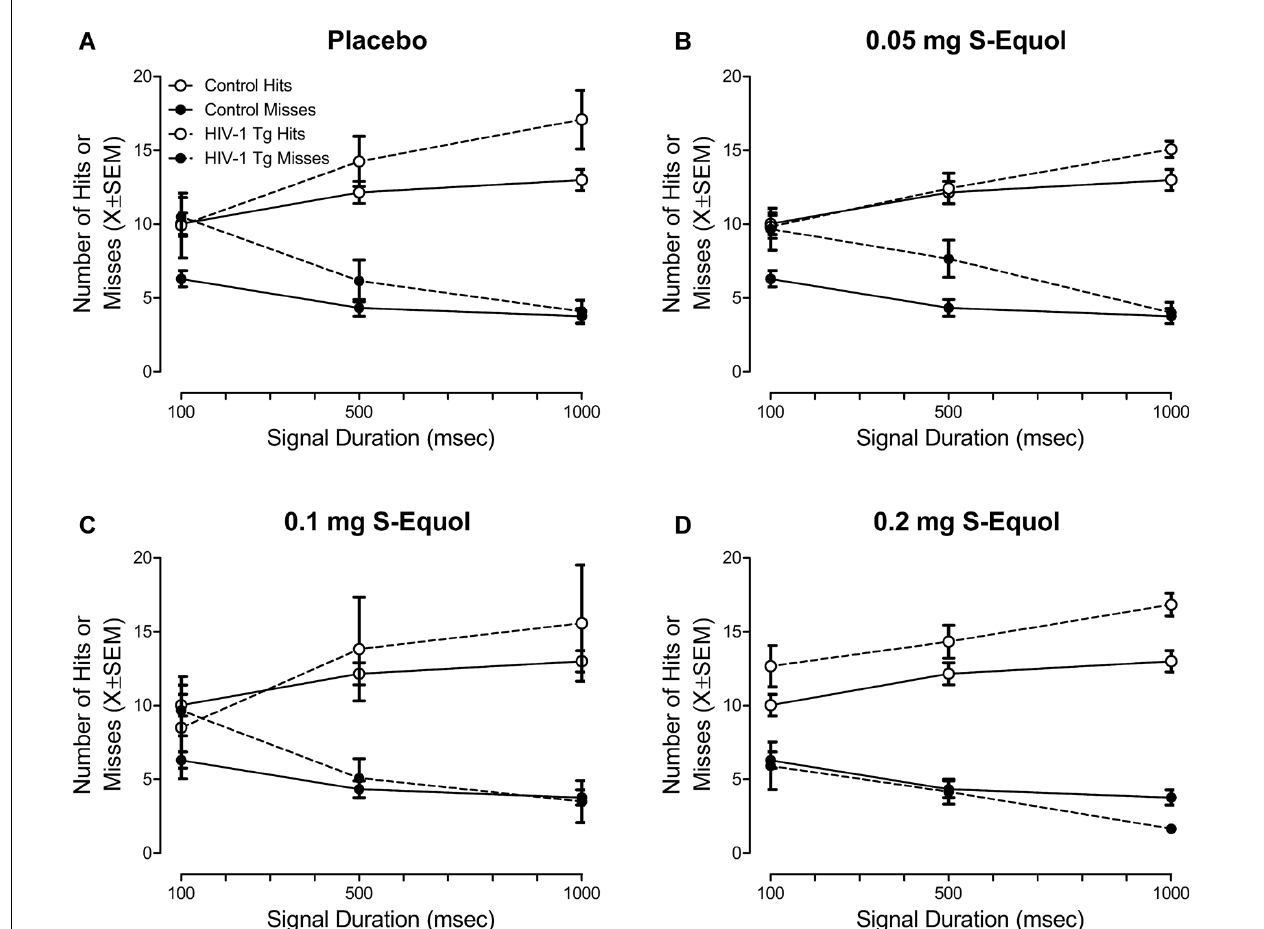
FIGURE 4 | The effect of S-Equol (SE) dose [Placebo (A) , 0.05 mg (B) , 0.1 mg (C) , 0.2 mg (D) ] on sustained attention was assessed in a signal detection operant task with varying signal durations. There was no significant effect of SE dose on sustained attention in control animals, thus data for control animals were collapsed across all doses. The top 40% of HIV-1 Tg animals, determined using percent accuracy, are presented for each dose. HIV-1 Tg animals continued to exhibit deficits in sustained attention relative to control animals when treated with placebo, 0.05 mg SE, or 0.1 mg SE. However, sustained attention deficits were ameliorated, to the level of controls, in a subset (i.e., 40%) of HIV-1 Tg animals treated with 0.2 mg SE.